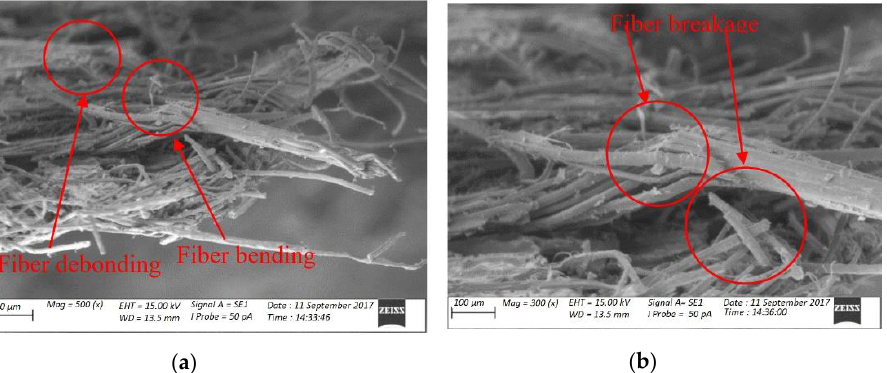
Figure 4. SEM images of fracture surface morphology of plain flax composites failed under impact loading at different magnifications ( a ) fibre debonding and bending; ( b ) fibre breakage reproduced from [167] MDPI, 2019.